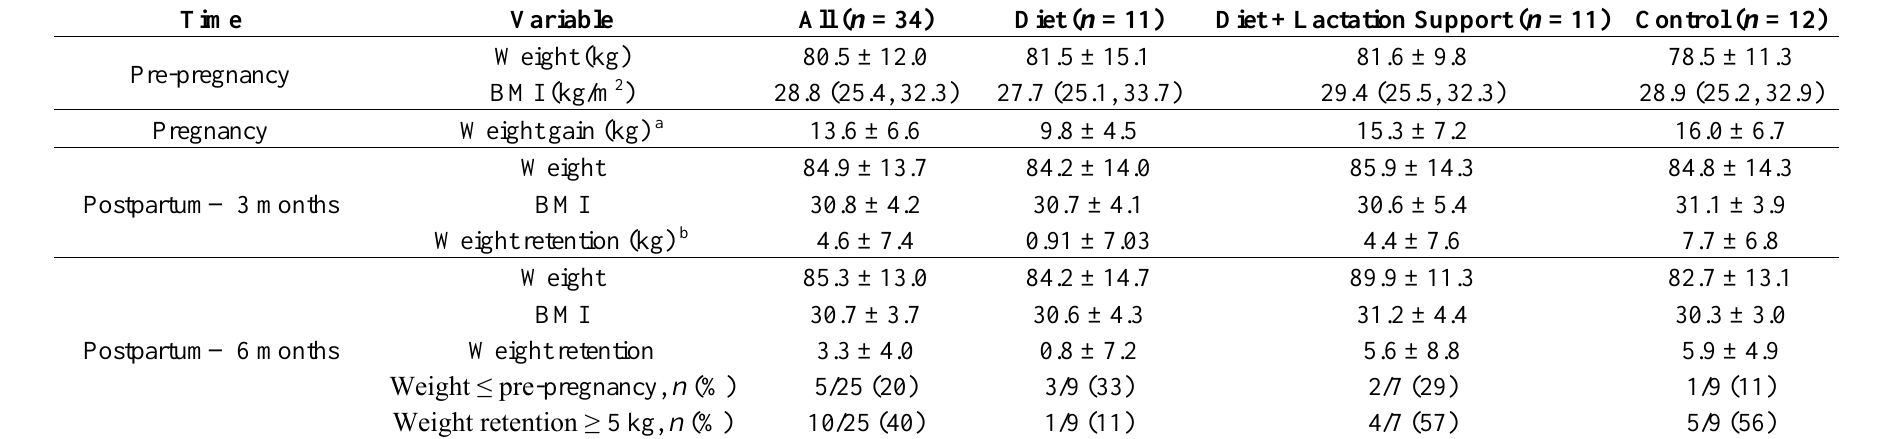
Table 2. Weight data for pilot randomised controlled trial participants.